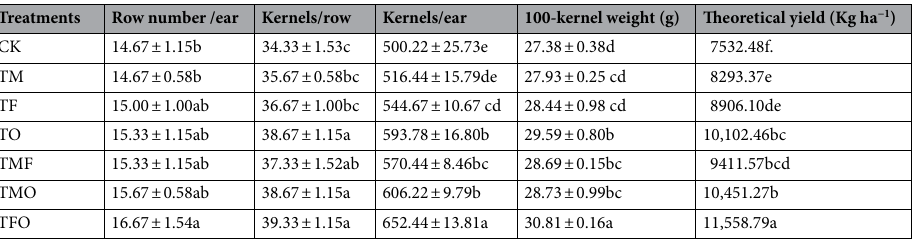
Table 3. Maize yield under different improved material treatments. CK: no modified material; TM: maturing agent (ferrous sulfate); TF: fly ash; TO: organic fertilize; TMF: maturing agent + fly ash, TMO: maturing agent + organic fertilizer; TFO: fly ash + organic fertilizer; BD, soil bulk density; SMC, soil moisture content. Different lowercase letters represent significant differences among different improved material treatments in the same